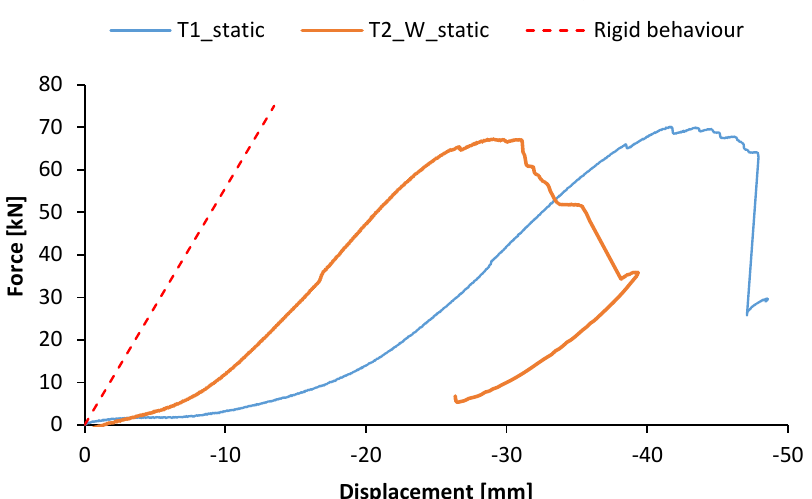
Figure 11. Load–displacement response of T1 and T2_W specimens tested in static loading condi ‐ tions.